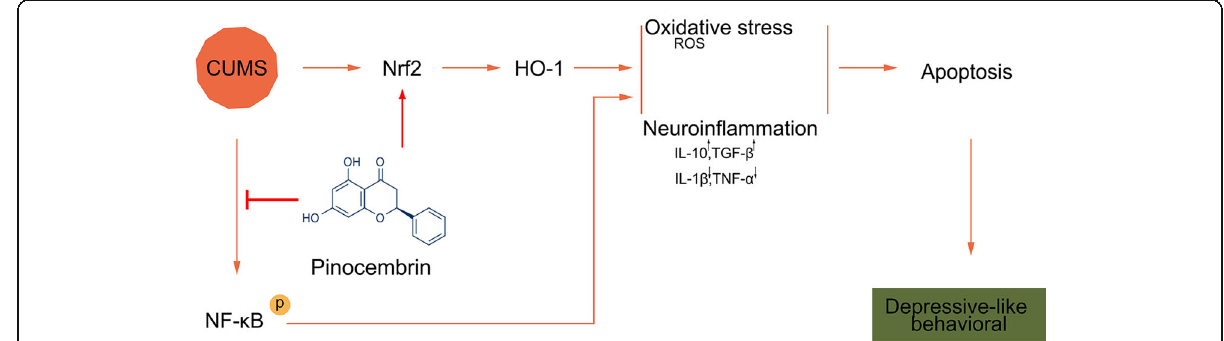
Fig. 7 This cartoon depicted PB activated Nrf2/HO-1 signal pathway but inhibited the phosphorylation of NF-kB, and then ameliorated neuroinflammation and oxidative stress, further inhibited cell apoptosis and mitigated CUMS-induced depressive-like